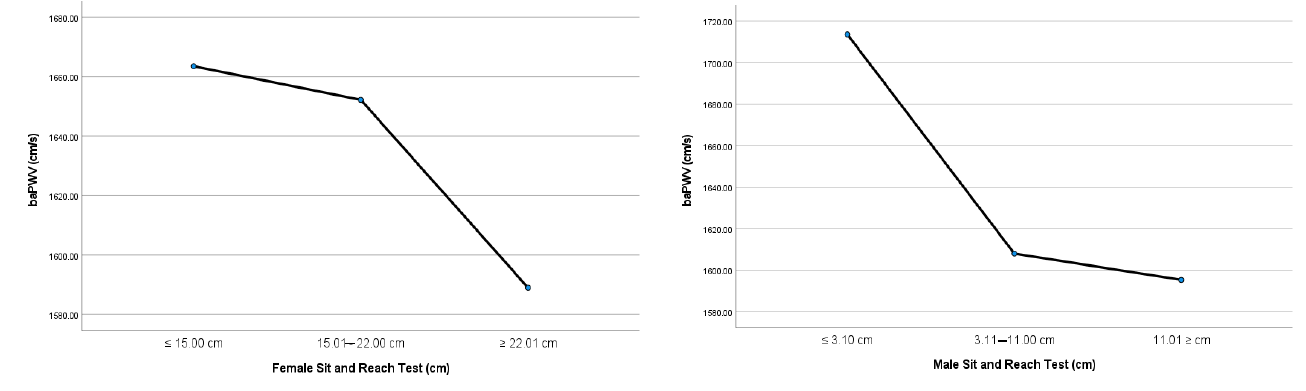
Figure 2. Comparison of the mean baPWV in each sit-and-reach test result tertile using mean plots. baPWV, brachial–ankle pulse wave velocity.